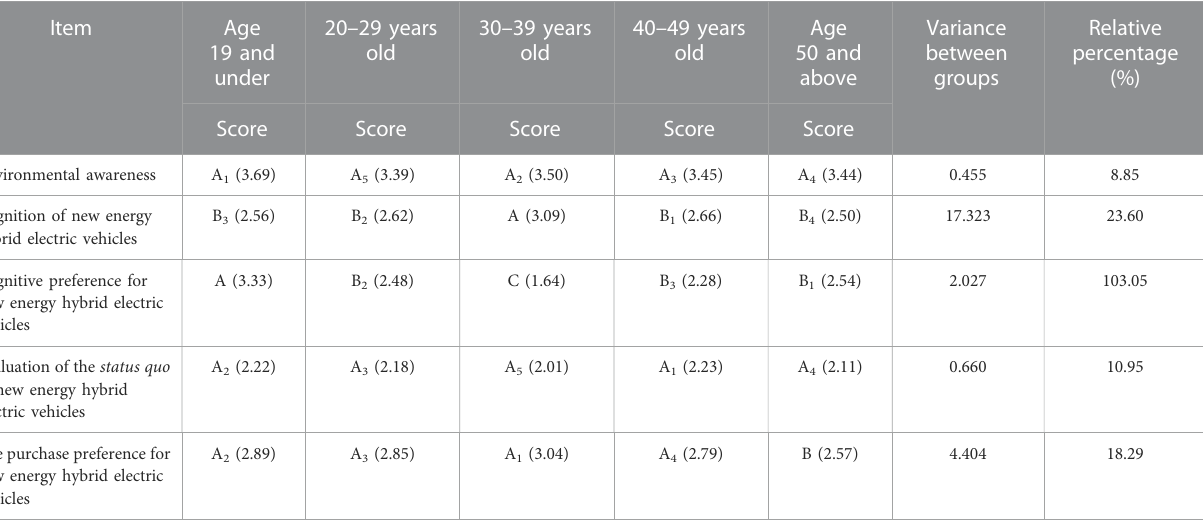
TABLE 7 Test results and ranking of different age groups.